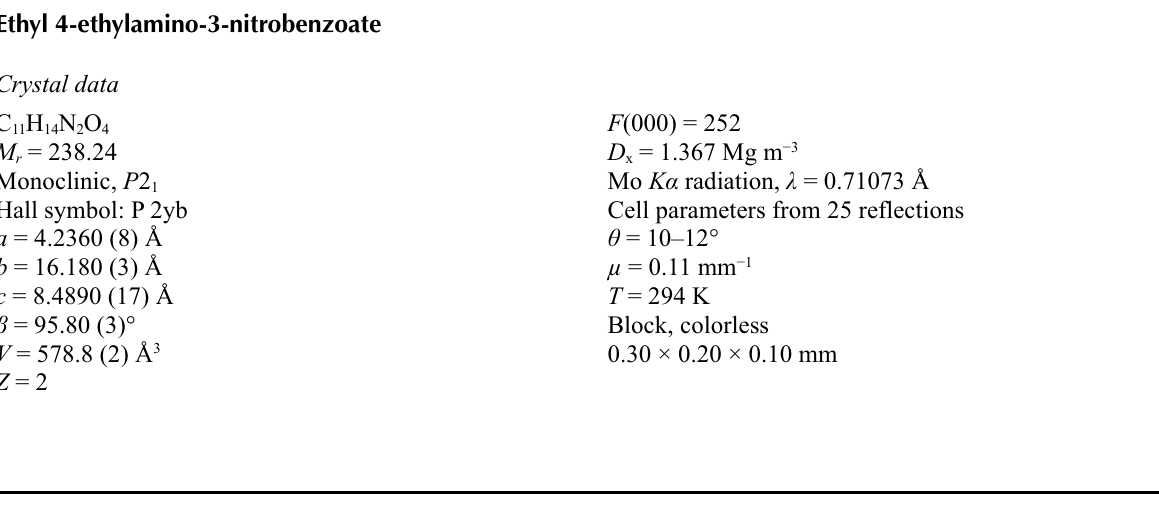
Figure 2 A partial packing diagram of the title compound. Hydrogen bonds are shown as dashed